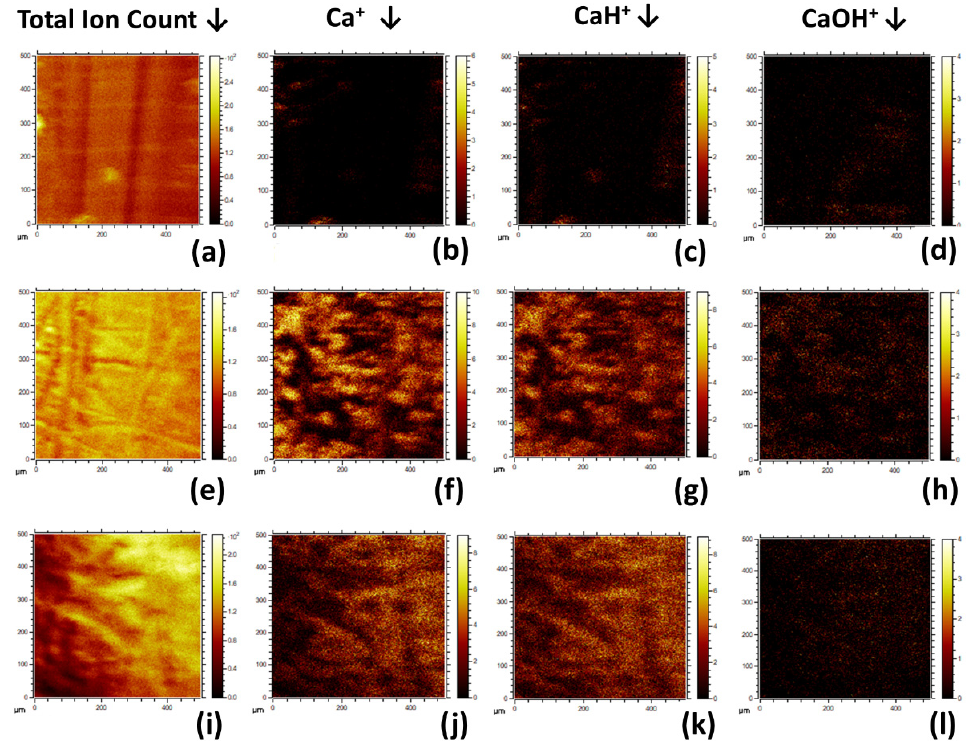
Figure 10. Positive Polarity ToFSIMS maps for 0HA (( a ) Total Ion Count) (( b ) Ca + ), (( c ) CaH + ), (( d ) CaOH + ), 5HA (( e ) Total Ion Count) (( f ) Ca + ), (( g ) CaH + ), (( h ) CaOH + ), and 30HA (( i ) Total Ion Count) (( j ) Ca + ), (( k ) CaH + ), (( l ) CaOH + ). For scale, each positive ion image is 500 µm × 500 µm. The ion intensity of each image is highlighted by the scale bar located to the right-hand side of each image.